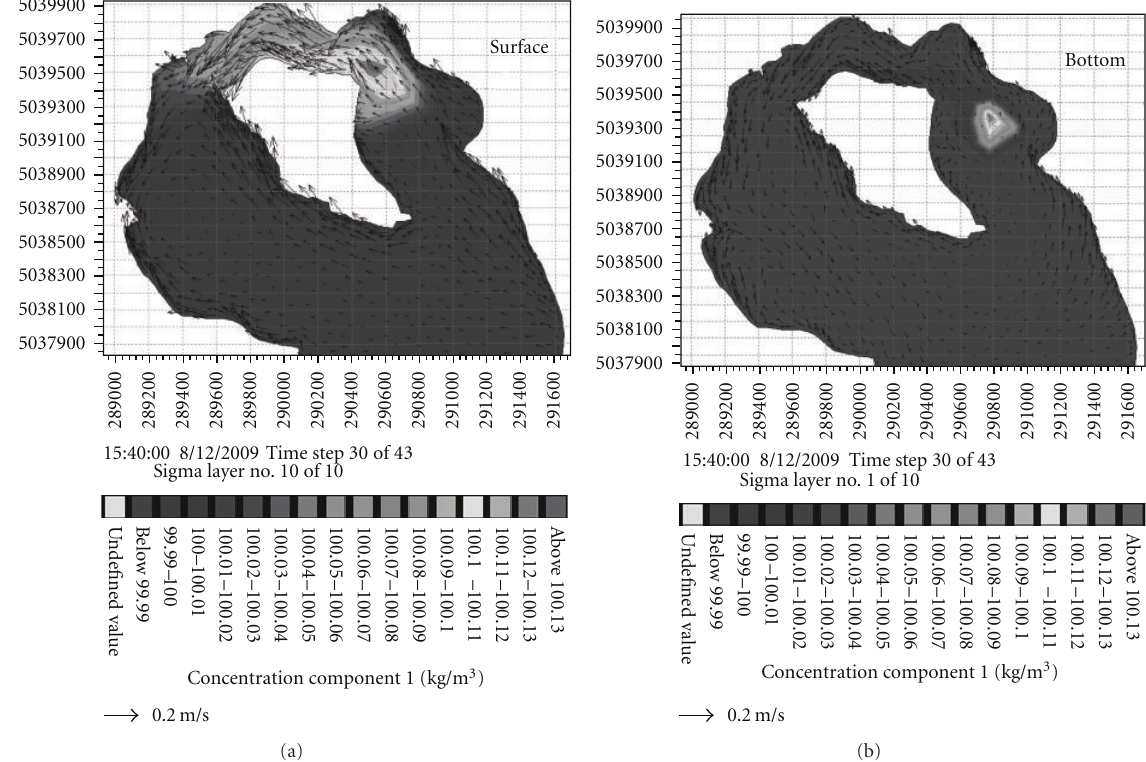
Figure 14: The simulated flow patterns in the surface and bottom layers, driven by a constant east wind of 10m/s after model simulates for 5 hours in realtime starting from rest.